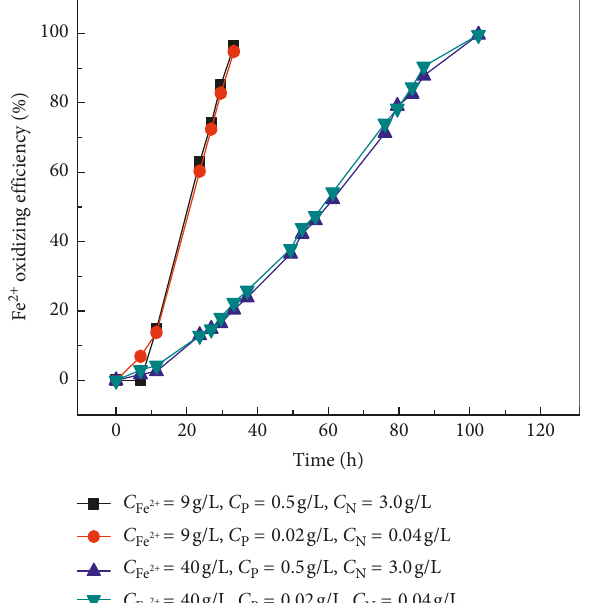
Figure 4: Fe 2+ oxidizing efficiency vs. time at different nitrogen and phosphorus